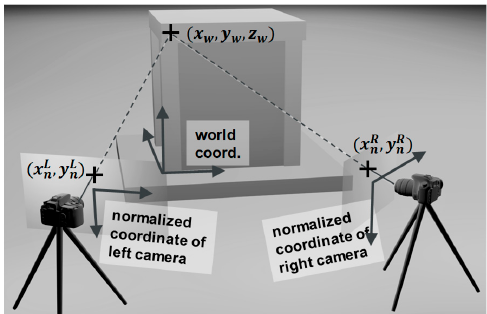
Figure 9. Three-dimensional positioning by using stereo triangulation. Two cameras are needed to position arbitrary point in three dimension.